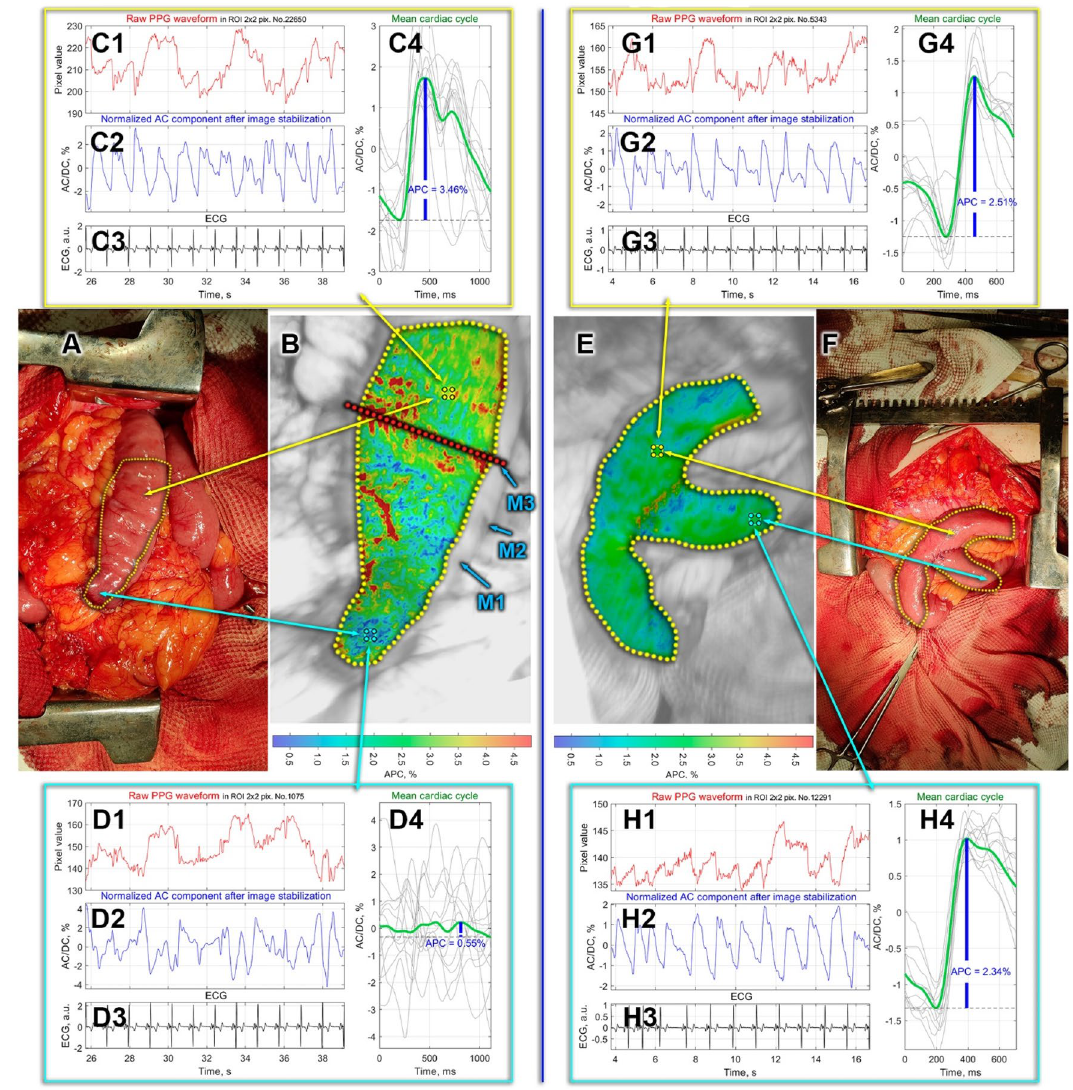
Figure 1. Intestinal blood perfusion in the case of T-shaped anastomosis. Panels ( A , F ) are photographs of the patient’s bowels before and after jejunojejunostomy, respectively. Yellow dashed lines in these panels mark the areas within which mapping of the perfusion was assessed. Spatial distributions of the amplitude of the pulsatile component (APC) before and after anastomosis are shown in Panels ( B,E ), respectively. APC maps are overlaid on the respective intestine images. The boundaries of zones with different levels of perfusion according to the surgeon’s assessment are designated as M1–M3. The red dashed line in panel ( B ) indicates the final dissection line. The color bars in the bottom of Panels ( B,E ) show the APC as a percentage: more reddish, more perfusion. Panels ( C,D ) and ( G,H ) demonstrate PPG pulses in selected Region-Of-Interest (ROI sizing 2 × 2 pixels or 0.04 × 0.04 mm 2 ) before and after anastomosis, respectively. Each ROI in which we show the PPG waveforms is centered on either yellow or cyan circle marked on APC maps. There are four graphs in each panel designated as X1, X2, X3, and X4 (X = A, C, G, or H). Graph X1 shows PPG waveform calculated in the selected ROI without image stabilization. X2 is the ratio of alternating and slow varying components of the PPG waveform in the same ROI after image stabilization, law-pass filtering, and signal inversion. X3 is ECG signal synchronously recorded with video frames. Graph X4 shows one-cardiac-cycle pulse wave (thick green line) obtained after averaging of particular pulse waves (thin gray lines) over 12 cardiac